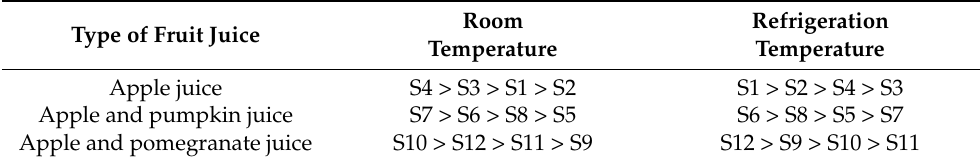
Table 3. Ranking of juice samples according to decrease in pH